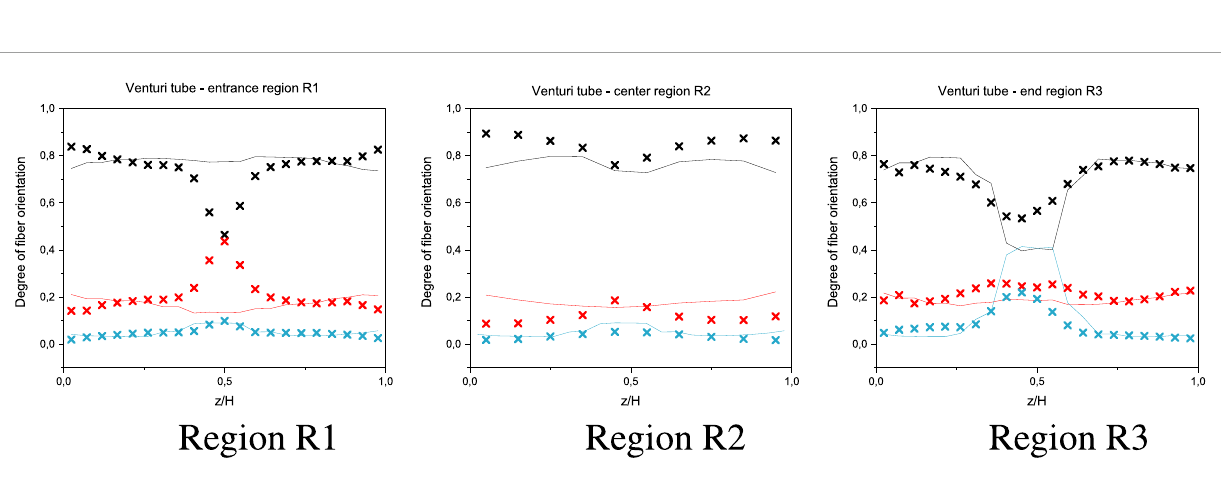
Frontiers in Materials